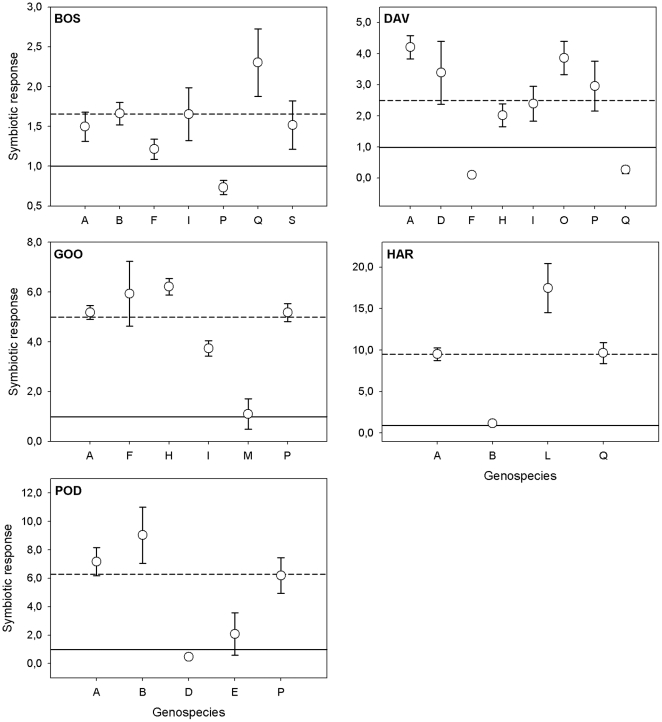
Symbiotic response of five genera of host plants to rhizobial strains classified as members of distinct phylotypes based on RFLP analysis (note that strains belonging to a given phylotype potentially represented isolates from more than one host).The solid line at 1 on the y-axis indicates the level where the host did not gain or lose anything from the rhizobial interaction relative to the N− control treatment. The dashed line is the average symbiotic response to all rhizobial phylotypes. Error bars are based on standard errors of means (if not visible, they are smaller than the symbols). Host species abbreviations are as in Fig. 1. Note the different y-axis scales between figure panels.